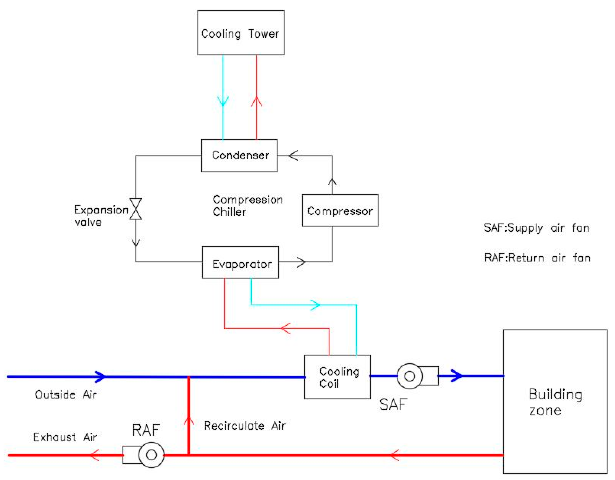
Figure 5. Schematic diagram of the conventional vapor compression cooling system.